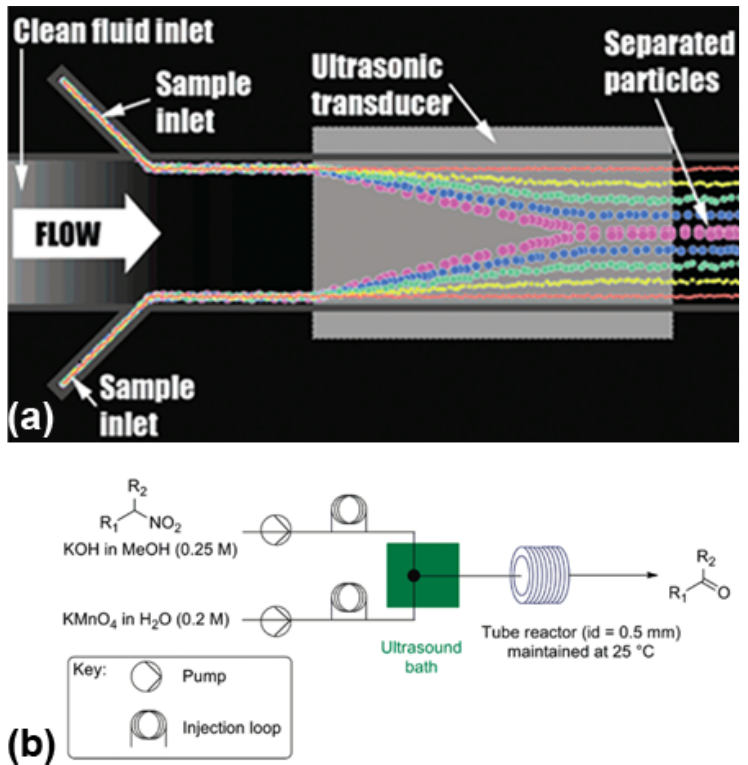
Figure 6. ( a ) The separation of microparticles via acoustic streaming in microfluidics (Reprinted with permission from [25]. Copyright 2007 American Chemical